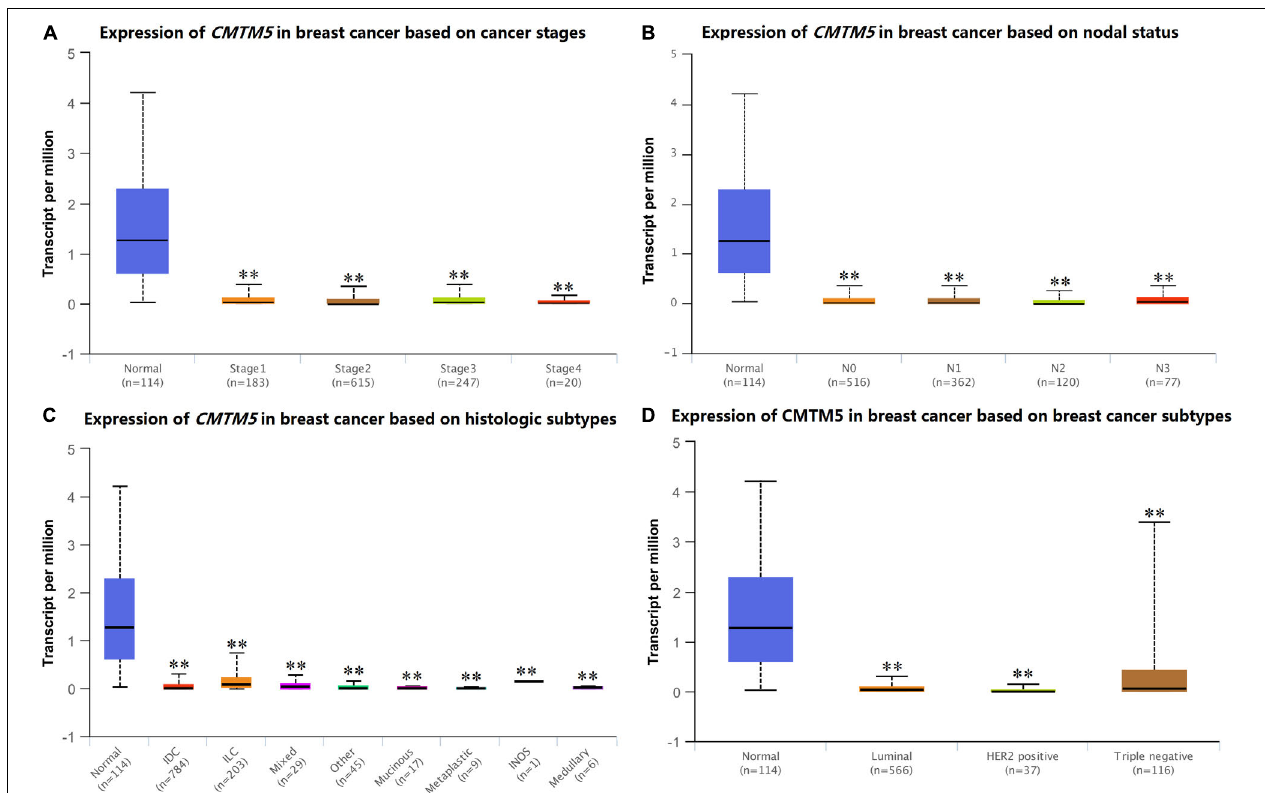
FIGURE 5 | mRNA expression levels of CMTM5 in breast cancer according to different clinicopathological characteristics from the UALCAN database ( ∗∗ P < 0.01). (A) Tumor stage, (B) nodal stage, (C) histologic subtypes, and (D) breast cancer